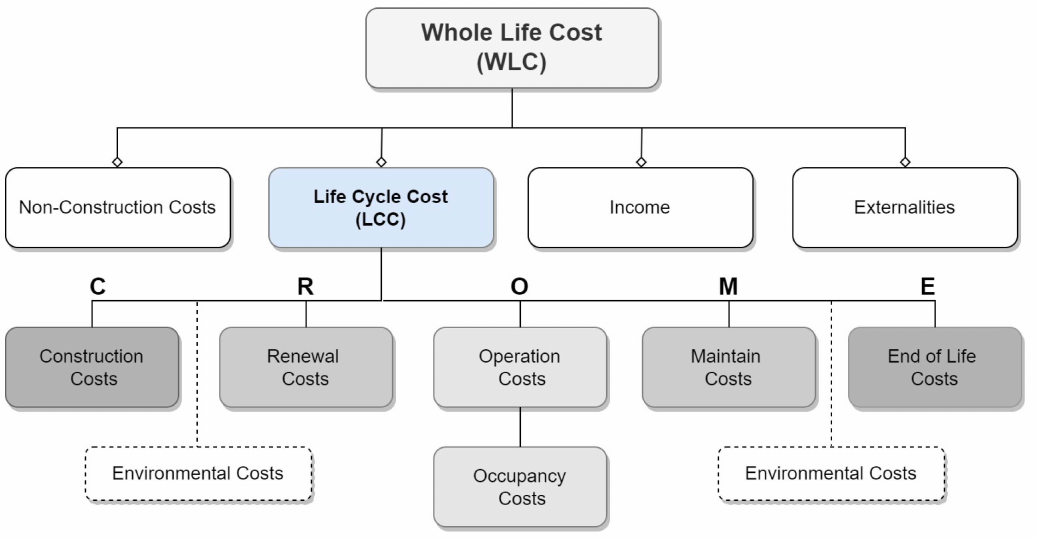
Figure 1. The difference between LCC and WLC